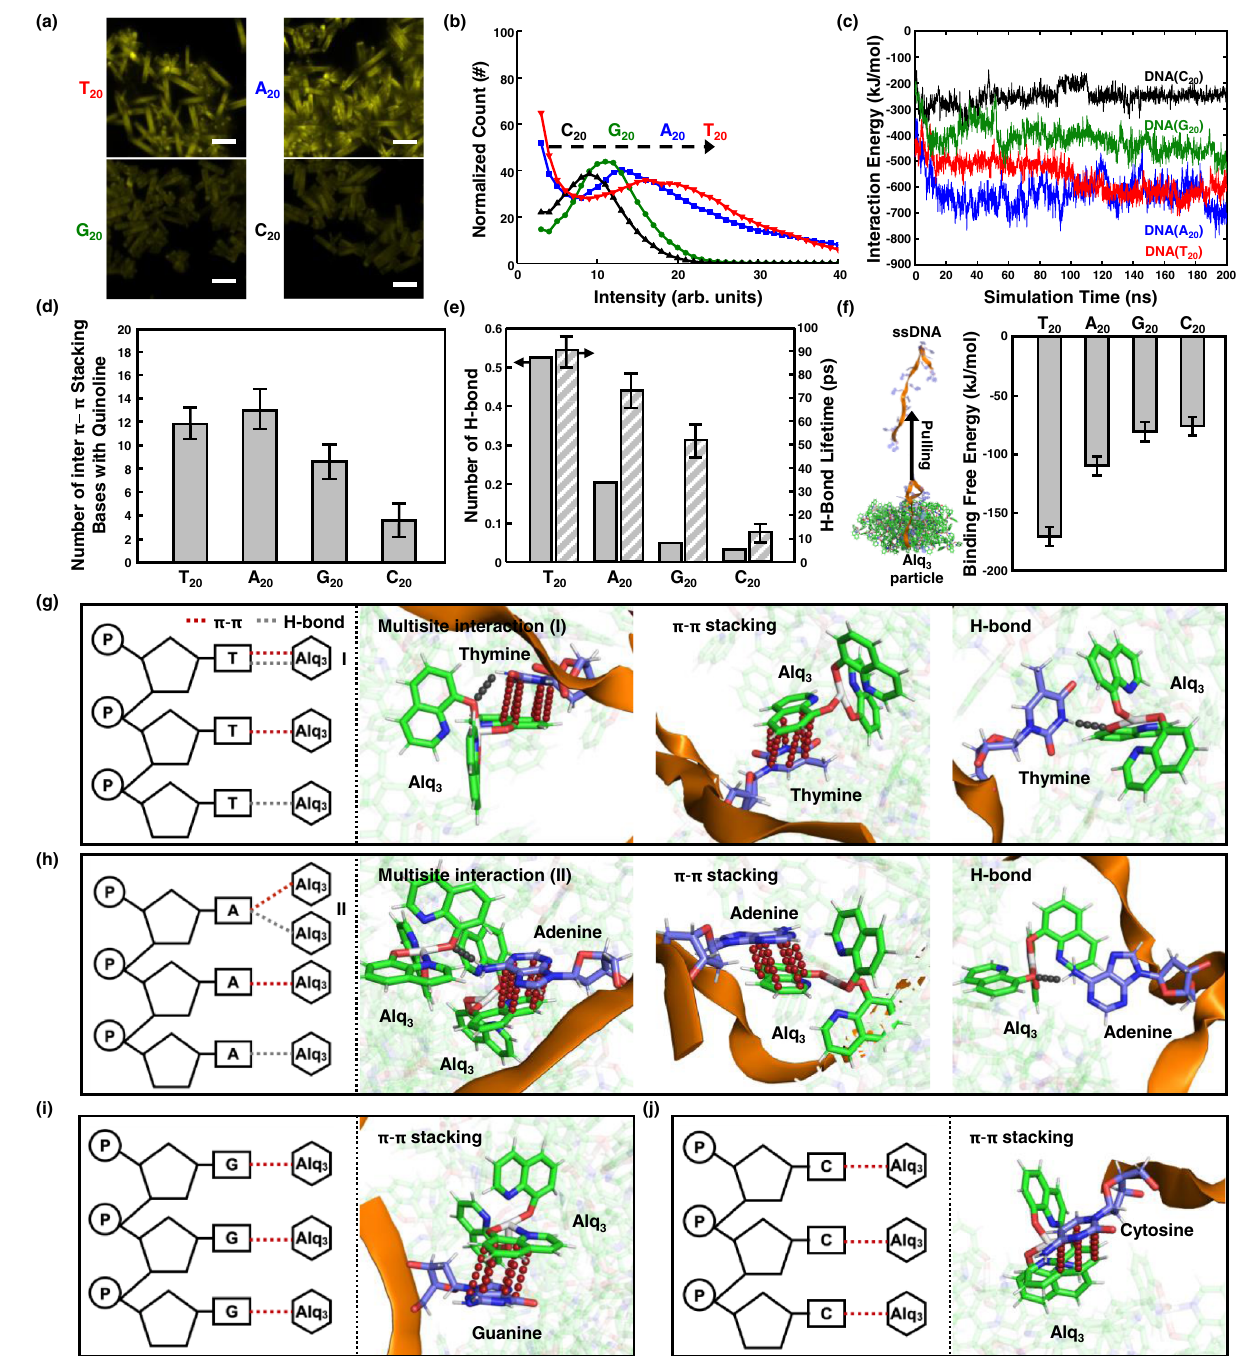
Fig. 3 | Effect of base units on molecular doping of DNAs possessing distinct obtained from umbrella sampling for three replicates of DNAs fully adsorbed on intermolecular interactions. a Fluorescent analysis of doped DNA(T 20 , A 20 , G 20 , Alq 3 particles.Theschematicsandmolecularviewsof( g )T 20 ,( h )A 20 ,( i )G 20 ,and( j ) and C 20 )-Cy3 in Alq 3 particles. CLSM images are obtained with excitation by a C 20 doped in Alq 3 particles from the fi nal 10ns of AA MD simulation. Three key 555nm laser (scale bar, 10 μ m). b Quantitative histogram of doped DNA-Cy3 using interactions, including multisite interaction, stoichiometric π - π stacking, and CLSM. Molecular dynamics simulations for the base-dependent incorporation of hydrogen bonding, for doping of T 20 and A 20 into Alq 3 are shown in ( g ) and ( h ), respectively. π - π stacking interactiondoping G 20 and C 20 into Alq 3 are shownin( i ) DNAsintoAlq 3 microparticles. c Time-tracedtotalinteractionenergybetweenAlq 3 particles and DNAs. d Number of bases that form inter π - π stacking with the qui- and ( j ), respectively. The hydrogen bonds and π - π stacking interaction in sche- noline of Alq 3 assembly during simulation. e Number of hydrogen bonds formed maticsandmolecularviewsaredepictedingrayandreddashedlines,respectively. between Alq 3 molecules and DNAs and their corresponding lifetimes during the Errorbarsin( d ),( e ),and( f )representstandarddeviation.Sourcedataareprovided fi nal 100ns simulation. f Binding free energy of the DNAs on Alq as a Source Data fi 3 assembly,